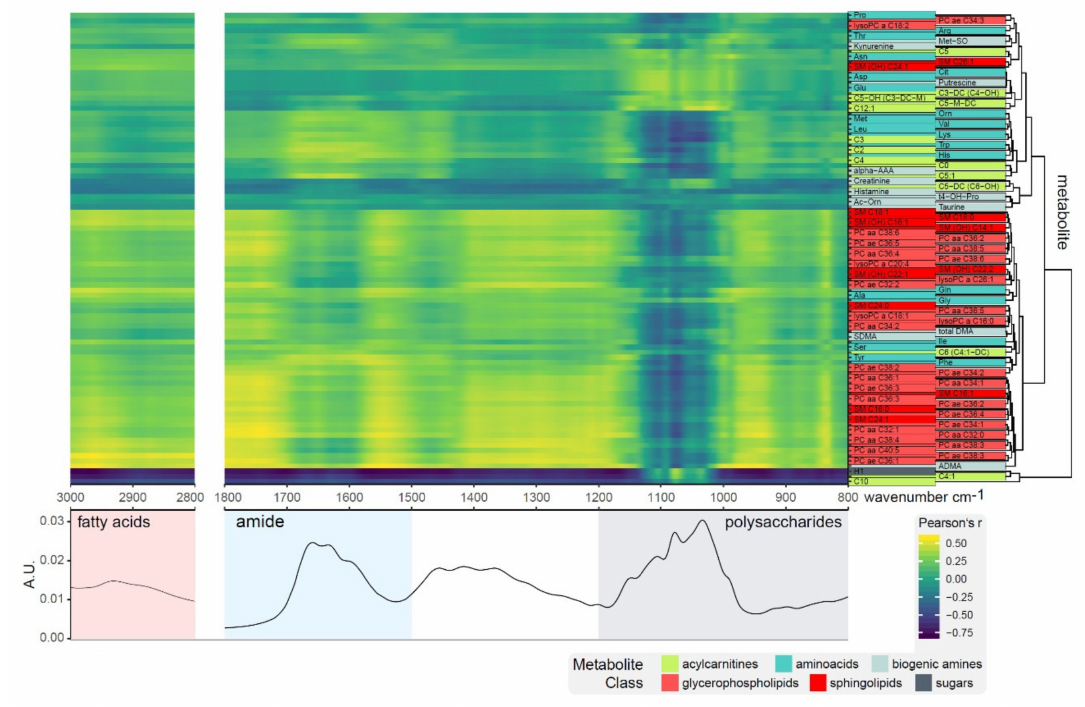
Figure 2. Correlation profiles of metabolite concentrations with fatty acid, amide, and polysaccharide regions of the FTIR spectra for 4 h control samples. Clustering of metabolites revealed three distinct groups of small molecules; a cluster containing glucose correlating well with the polysaccharide band (1200–1000 cm − 1 ); a second cluster primarily made up of lipids correlating well with the lipid region (3000–2800 cm − 1 ); and a third cluster of amino acids, biogenic amines, and